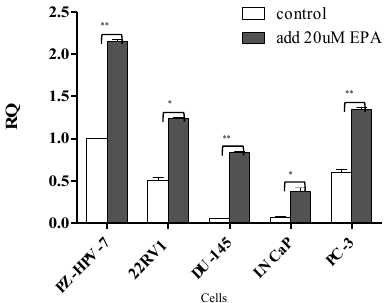
Figure 2. Comparison of the miR-378 expression levels before and after EPA treatment in each cell, measured by quantitative real-time polymerase chain reaction (qRT-PCR). EPA untreated (white bar) and EPA treated (black bar). Y -axis risk quotient (RQ) = tumor cells/reference sample. The PZ-HPV-7 cell was used as a reference sample, and its quality was normalized to 1, then further compared with other treated or untreated EPA cells. The data presented in the figure are the mean ± standard deviation. * represents p < 0.05, ** represents p < 0.005.